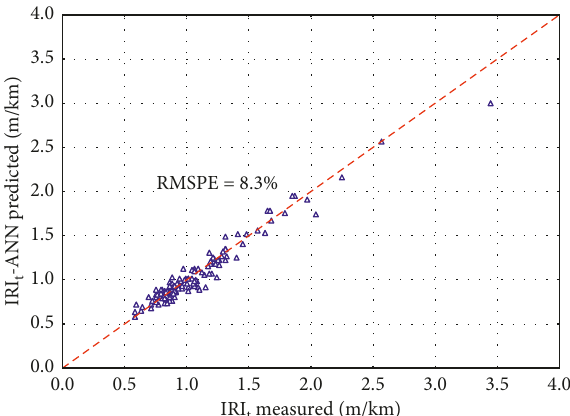
Figure 9: Measured versus predicted IRI training data.